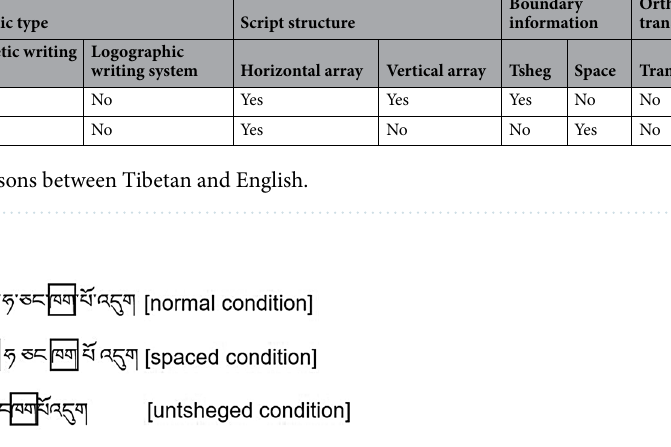
Figure 1. A sample Tibetan sentence displayed with different visual conditions (the boxes mean areas of interest). Translation: Today is the first day of the new